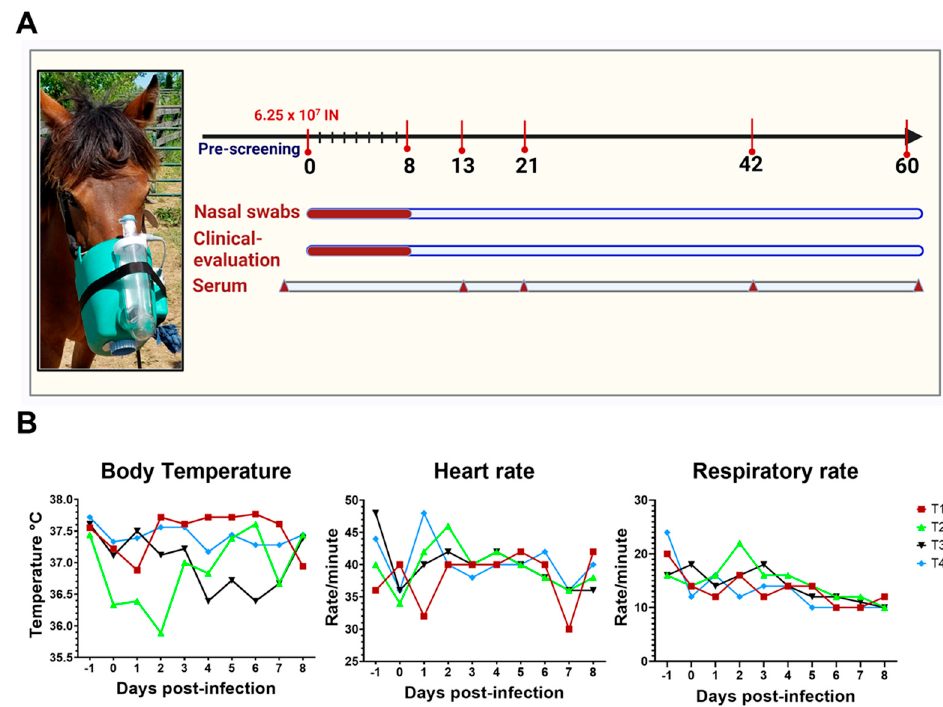
Figure 1. Experimental design and clinical outcomes of the D/CA2019 virus in horses. ( A ) Experi- mental plan—four 2-year-old horses (T1, T2, T3, and T4), seronegative for both influenza-D virus and also type A (H3N8) equine influenza, were intranasally inoculated with 6.25 × 10 7 TCID 50 /animal of influenza D/bovine/California/0363/2019 (D/CA2019) virus, using Flexineb, a portable equine neb- ulizer system. Clinical, virological, and serological parameters of infection were assessed following intranasal inoculation of D/CA2019. The clinical evaluation included the presence of influenza-like illness, nasal discharge, changes in body temperature, heart rate, respiratory rate, changes in the peripheral lymph nodes of the four horses, monitored for 8 days (shown in red highlights). To study the viral shedding, nasopharyngeal swabs were collected from 0 to 8 dpi and sera were collected at 13, 21, 42, and 60 dpi to check seroconversion. ( B ) Changes in the temperature, heart rate, and respiratory rate of the four horses. Each shape represents an individual animal. (T1: red square, T2: green triangle, T3: black inverted triangle, T4: blue diamond). The graphical illustration was created with BioRender.com, accessed on 28 January 2022.